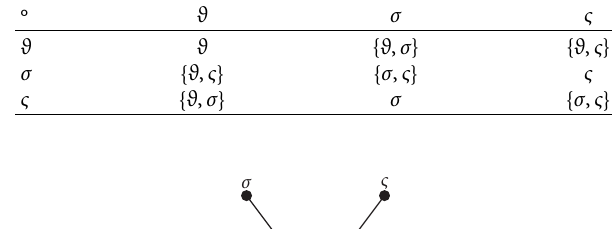
Table 1: Hyperoperation “ ° ”defned on Θ � ϑ , σ , ς { }